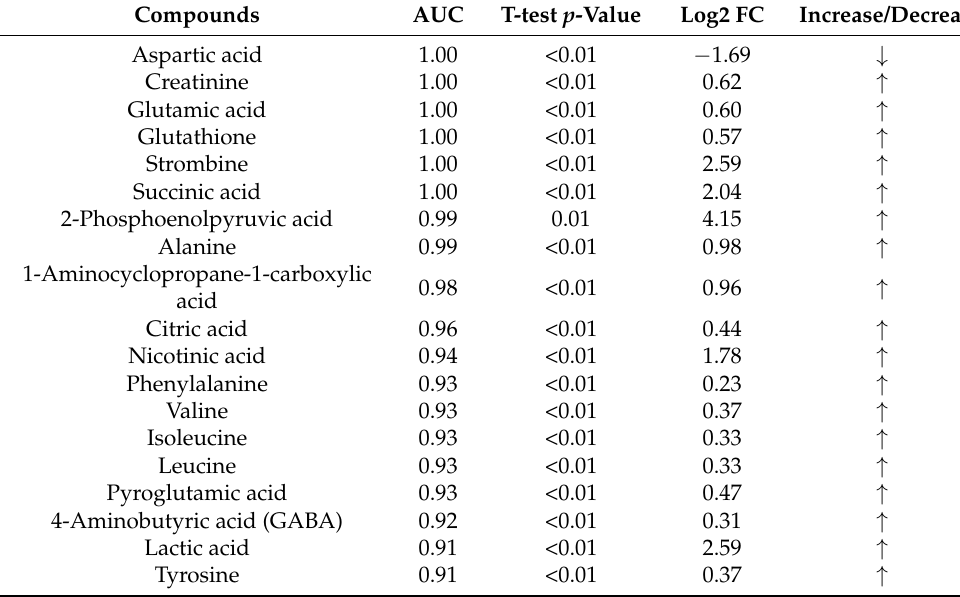
Table 4. Muscle metabolites with AUC greater than 0.9, identifying them as putative biomarkers for transport stress. The decrease or increase shows the change of metabolites in post-transported abalone relative to the control